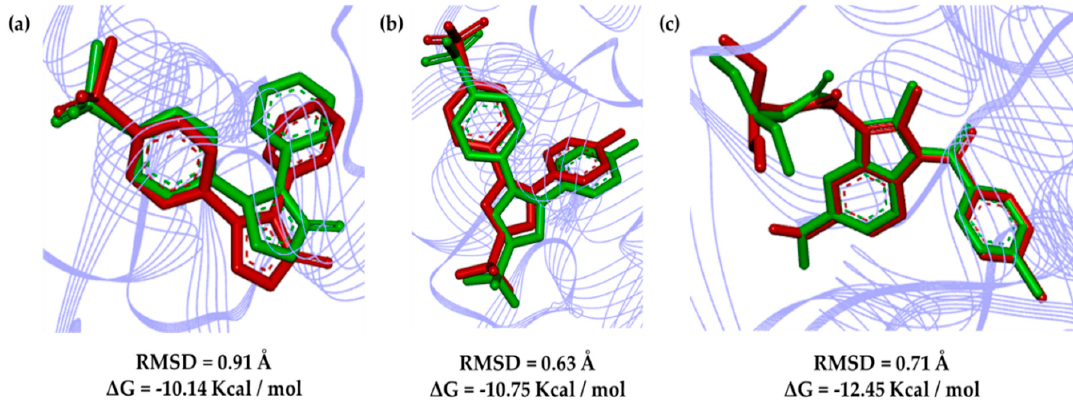
Figure 6. Overlapping poses of the crystallographic complexes (in green) with calculated poses (in red): ( a ) rofecoxib ( RCX ) for Homo sapiens (PDB 5KIR), ( b ) celecoxib ( CEL ) for Mus musculus (PDB 3LN1) and ( c ) indomethacin ( IMS ) Ovis aries (PDB 2OYE).